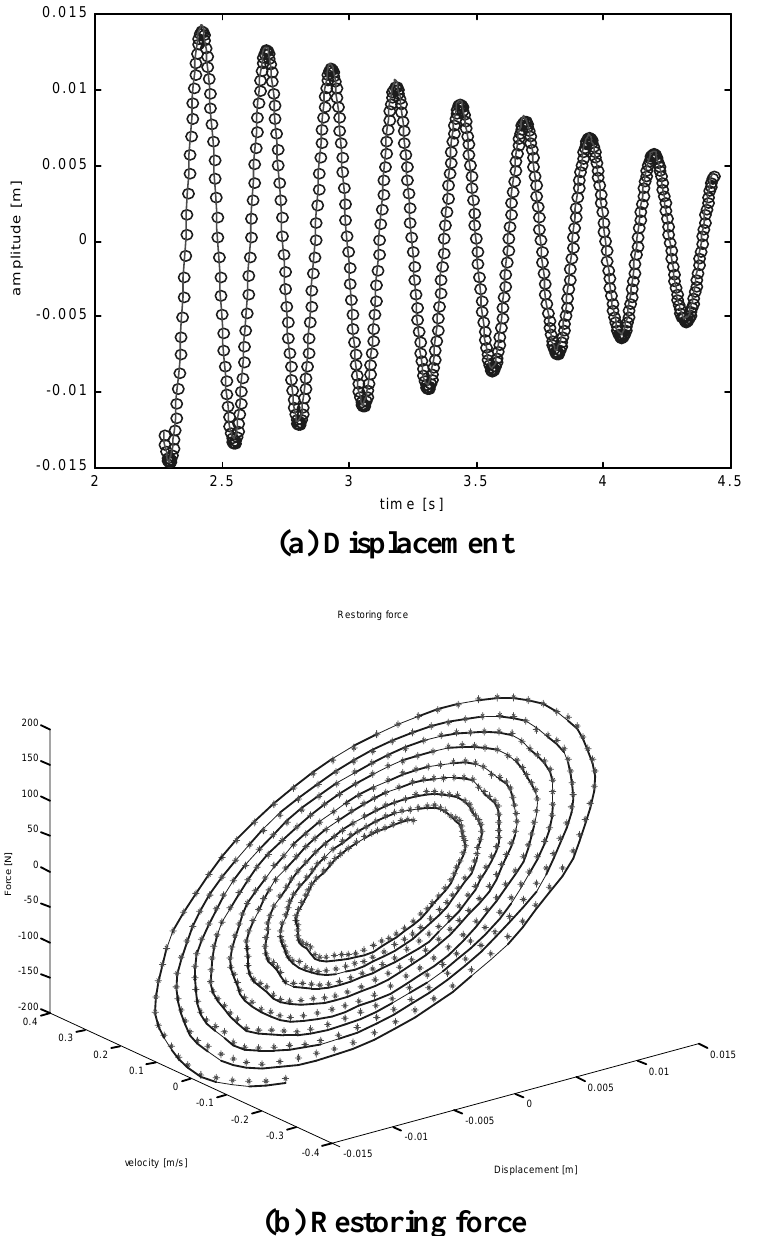
Fig. 6. Comparison between measured ( − ) and predicted (o) signals (RFS